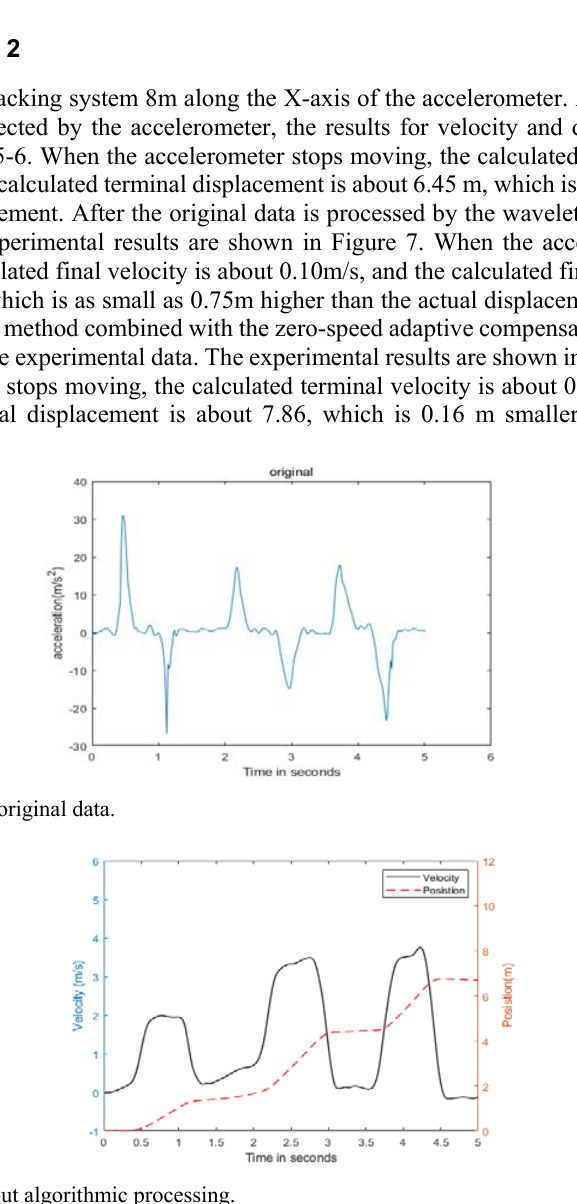
Fig. 6. Result without algorithmic